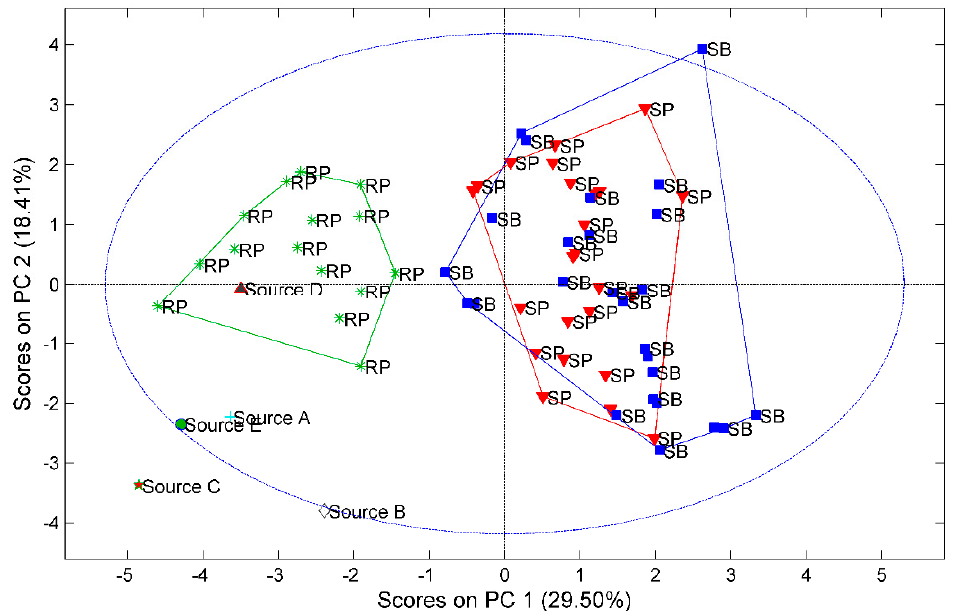
Figure 2. Principal Component Analysis (PCA) with ceramics fragments excavated in three archaeo- logical sites, Sambaqui do Bacanga (SB), Sambaqui da Panaquatira (SP), and Rabo de Porco 1 (RP), together with the five clay sources (A to